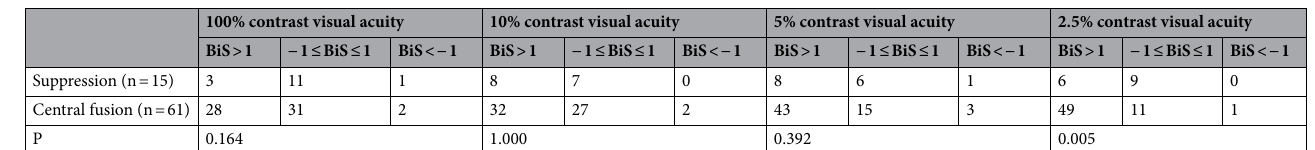
Table 4. The numbers of the patients with different BiS Scores in the groups with and without central fusion after strabismic surgeries. n number, BiS binocular summation.